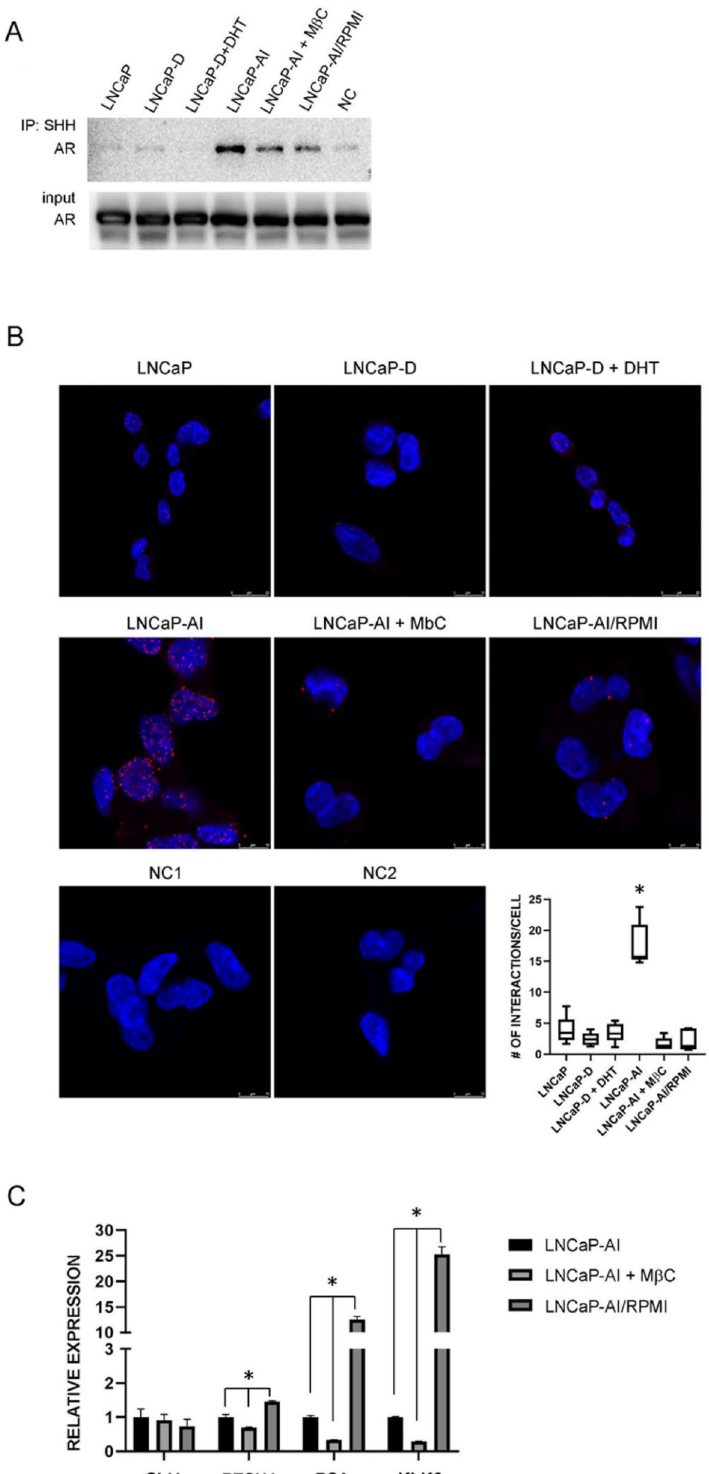
Figure 3. Evidence of SHH-N and AR direct interactions. ( A ) Co-immunoprecipitation analysis showed a direct SHH-N–AR interaction only in androgen-independent cells LNCaP-AI. The interaction was reduced after cholesterol depletion with MβC or by growing the cells in medium with non-CS-FBS (RPMI). ( B ) Proximity ligation assay confirmed this interaction, depicted by the highest number of red dots per cell in LNCaP-AI cells, also represented graphically, N = 6 for LNCaP cells and N = 5 for LNCaP-D, LNCaP-D + DHT, LNCaP-AI, LNCaP-AI + MbC and LNCaP-AI/RPMI. Nuclei are shown in blue, points of interaction are shown in red, NC—negative control. ( C ) Cholesterol depletion downregulated AR signaling activity, suggesting that the SHH-N–AR interaction sustains AR activity in androgen-independent cells. Growing the cells in medium with non- CS-FBS upregulated AR signaling, confirming higher affinity of AR for androgen. *Indicates P <